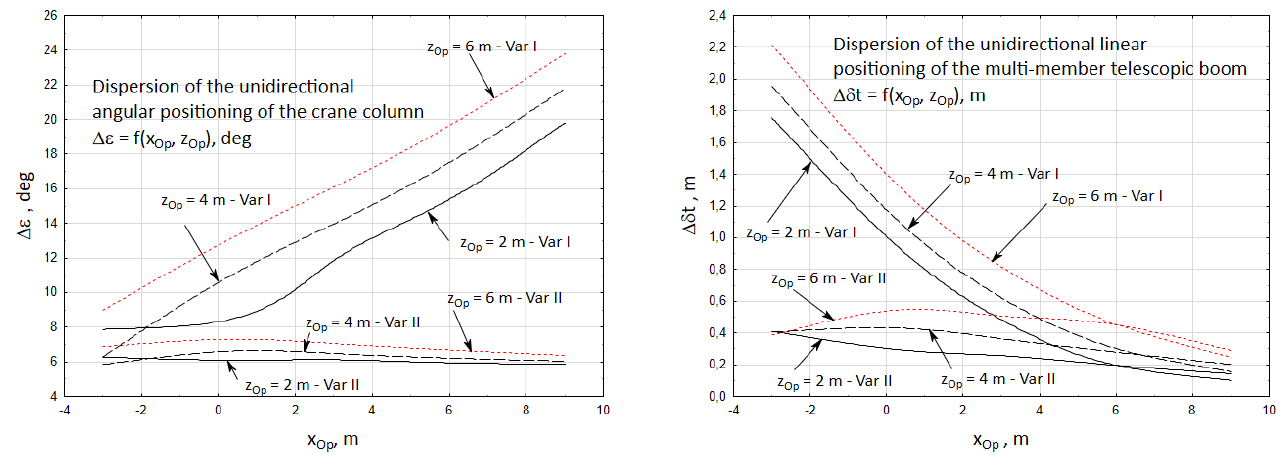
Figure 11. The accuracy of the initial unidirectional positioning of the cargo.